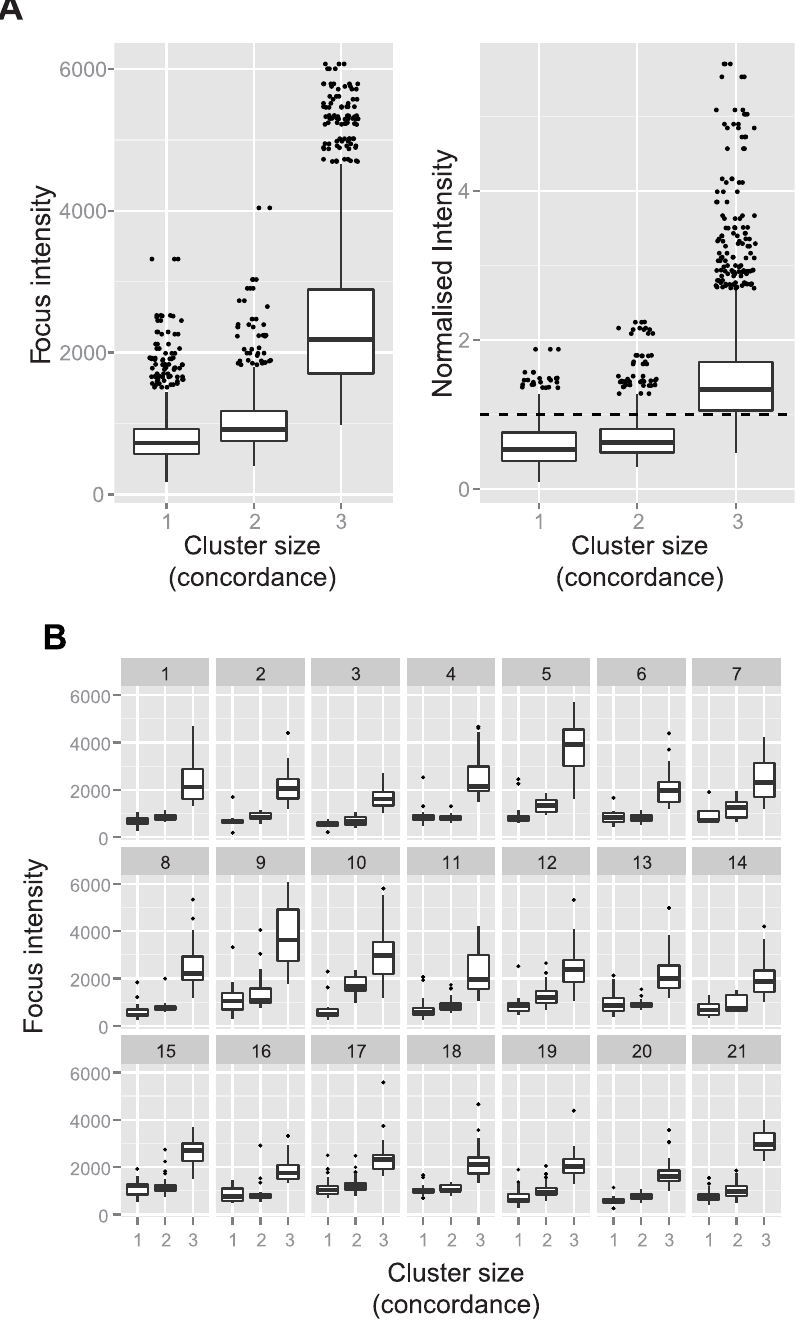
Figure 6. The average focus intensity is higher with increasing agreement between experimenters (cluster size or concordance). Greedy clustering was performed by first comparing foci selected by two experimenters using an 8 pixel radius. When the focus was selected by both experimenters, a cluster of size 2 was generated. Foci that were only picked by a single experimenter were used to seed a cluster of size 1. The clusters were compared to the third experimenter and any matches used to increase the cluster sizes such that matches between all three experimenters gave rise to cluster size 3. Clustering was performed using experimenter order 123, 231 and 312 and all results combined for plotting (A). Because experimenters clicked on slightly different parts of the focus, the focus intensity was calculated as the average pixel value